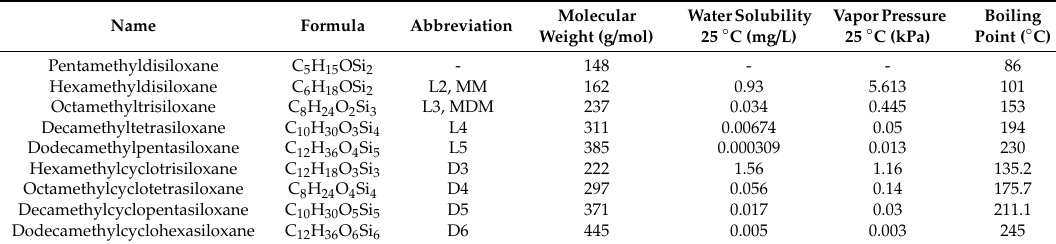
Figure 2. The repeating structural units for linear siloxanes (left) and cyclic (right) siloxanes. (e.g., n = 1: L2) [12]. Table 2. Names and physical properties of typical siloxane compounds in biogas [13,14]. Adapted from [14], MDPI: 2020.